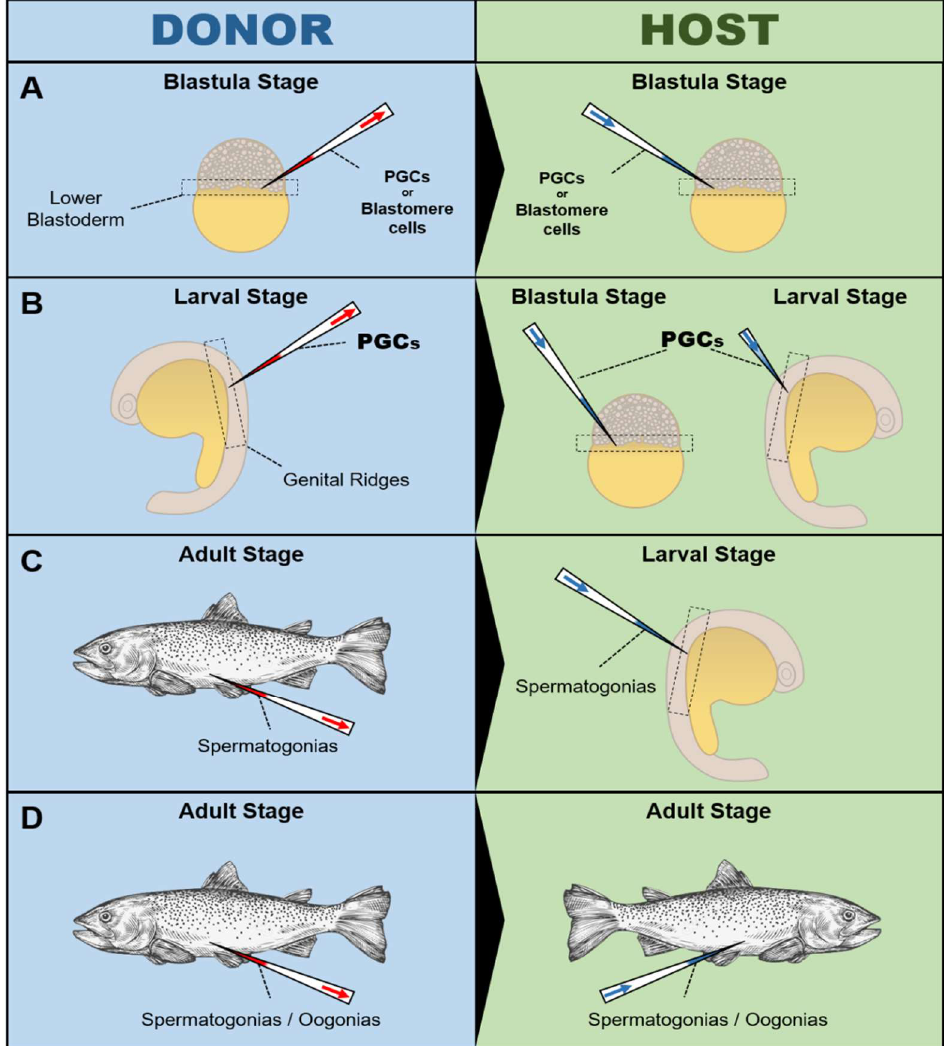
Figure 4. Germ cell transplantation. ( A ), Blastomere/differentiated primordial germ cells (PGCs) transplantation from embryo to embryo. ( B ), Differentiated PGCs transplanted from larvae to embryo and larvae. ( C ), Spermatogonial transplantation from adult to larvae. ( D ), Spermatogonials/Oogonias transplantation from adult to adult.